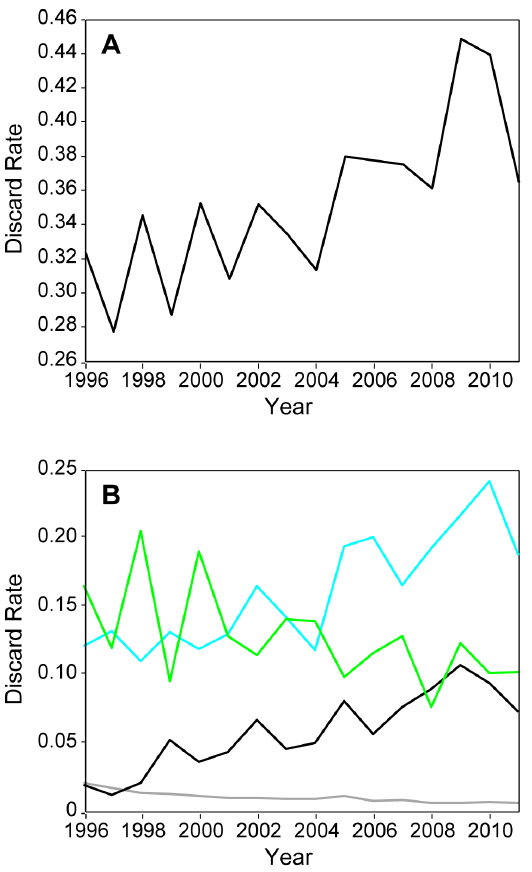
Figure 6. The proportion of the total observed catch estimated to be discarded. Panels indicate ( A ) the combined ratio of estimated discards consisting of the catches of pelagic stingray, snake mackerel, lancetfish, and 95% of the shark catch to total catch and ( B ) the ratio by species of Lancetfish (blue), snake mackerel (black), pelagic stingray (grey), and 95% of the shark catch (green) to total catch.